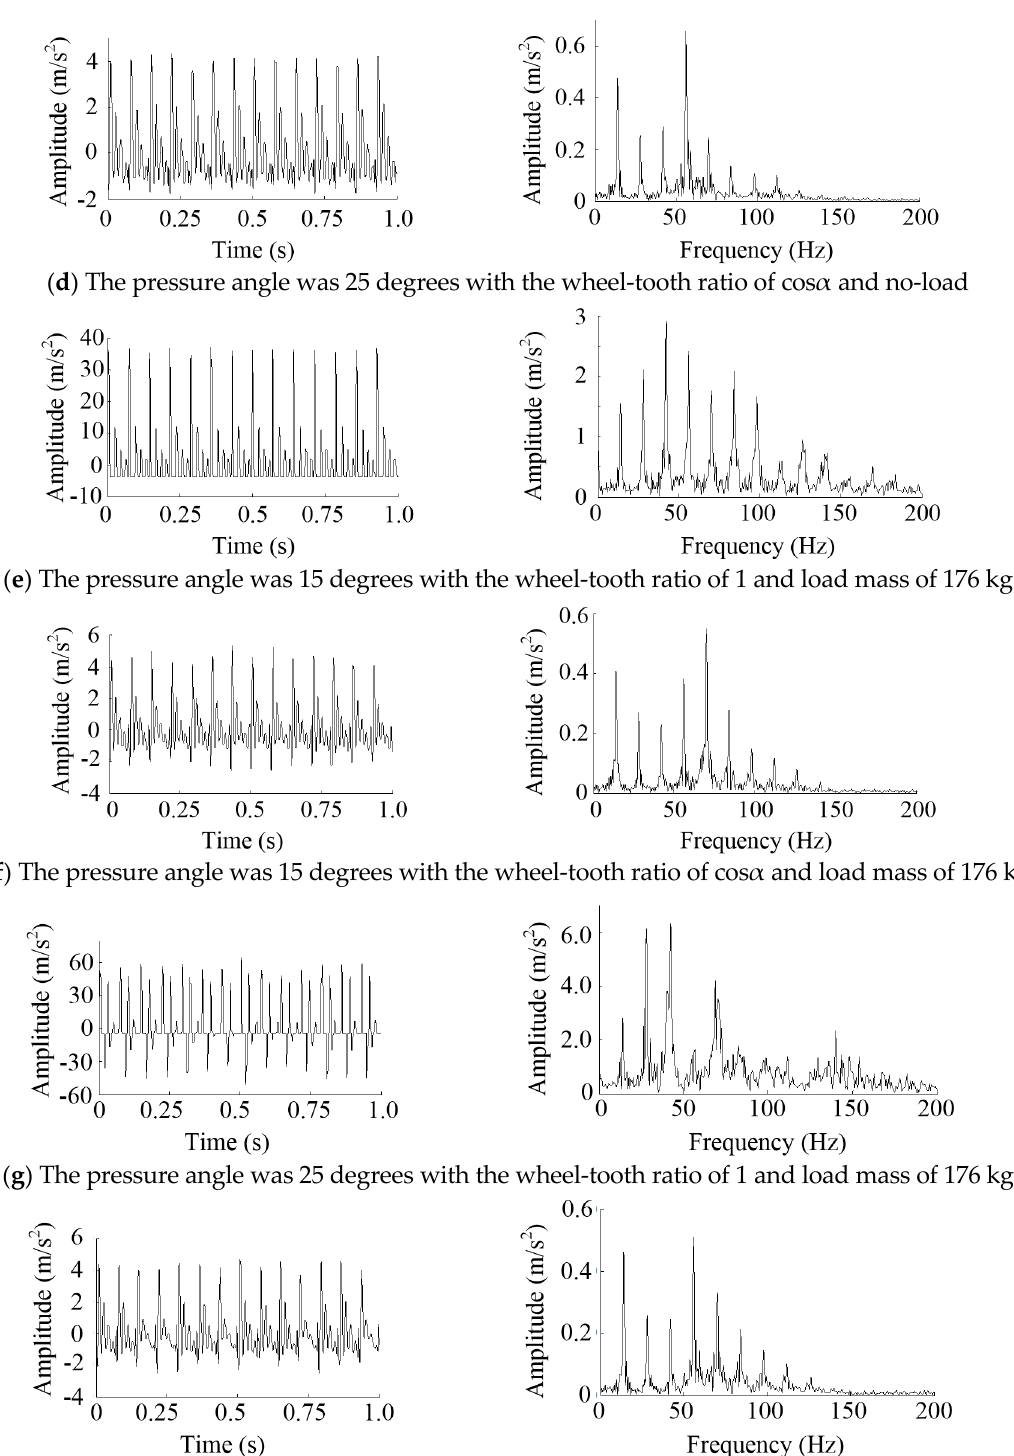
Figure 7. Time-domain and spectral of simulation results.